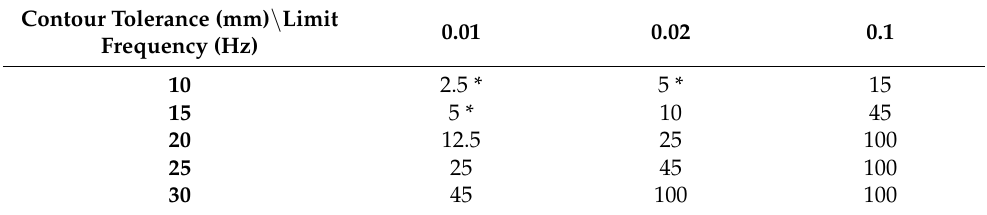
Table 2. Corner jerk threshold values (m/s 3 ) with respect to specific combinations of the contour tolerance limit (horizontal) and the limit frequency (vertical). Increasing corner jerk beyond the threshold values does not affect the value of the TV coefficient. The threshold values presented with * denote combinations for which a significant dependence on the axis jerk limit was found (see the commentary in the second half of this section). The values are based on the “Fan” toolpath results. Corner Jerk (m/s 3 ) Threshold Values with Respect to Contour Tolerance Limit (mm) and Limit Frequency